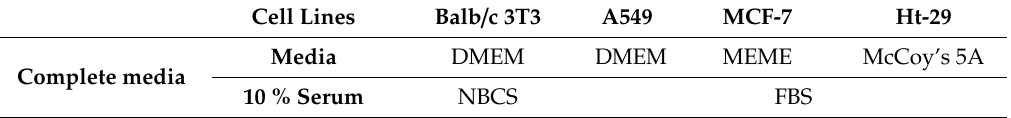
Table 1. The media and serum of each cell line used for cell